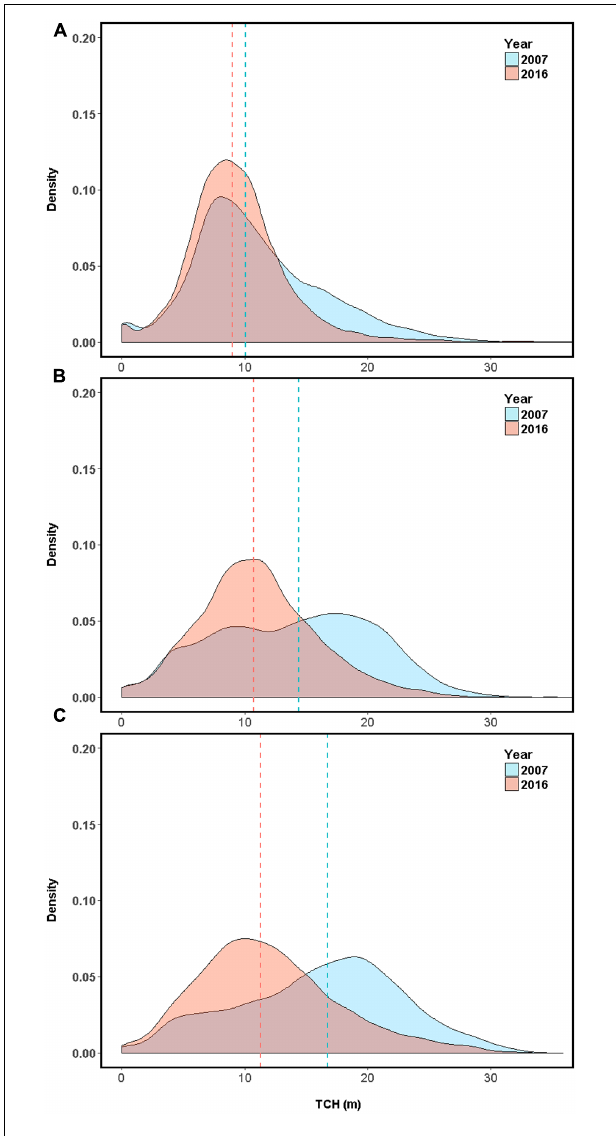
FIGURE 3 | Top-of-canopy height (TCH) distribution on the eastern slope of Mouna Kea volcano, Hawaii (155 ◦ 15 (cid:48) 54.63 (cid:48)(cid:48) W, 19 ◦ 56 (cid:48) 11.13 (cid:48)(cid:48) N) for (A) established tree invasion area dominated by alien Psidium cattleianum and Ficus rubiginosa (established-invasion) (B) tree invasion plus koa moth ( Scotorythra paludicola ) outbreak (invasion-outbreak). (C) Koa moth outbreak with minimal tree invasion (native-outbreak). Median values for each year are represented with dashed lines, with 2007 in blue and 2016 in